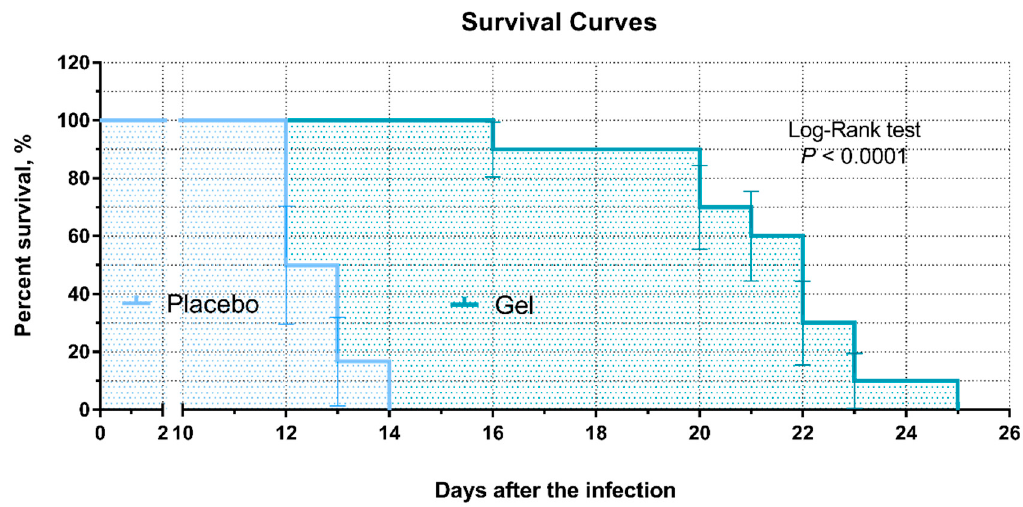
Figure 3. Survival plot of two studied groups. The log-rank (Mantel-Cox) test was used for analysis.